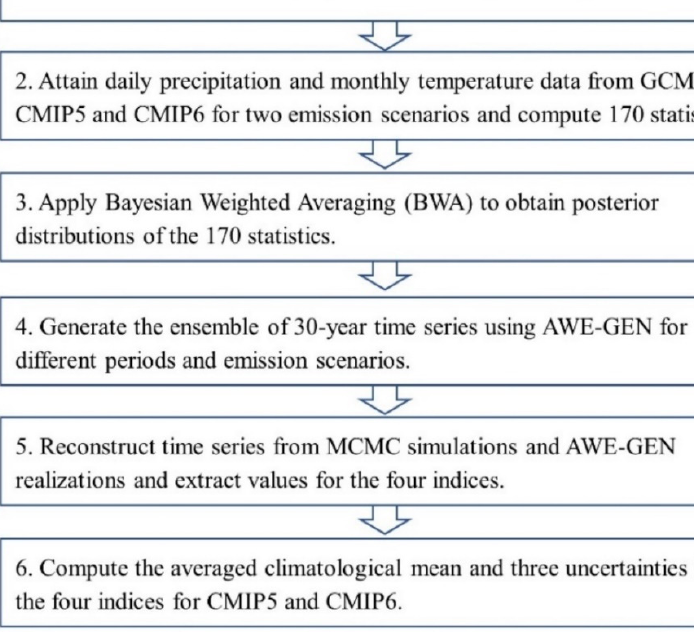
Figure 1. Flow chart of the methodology.